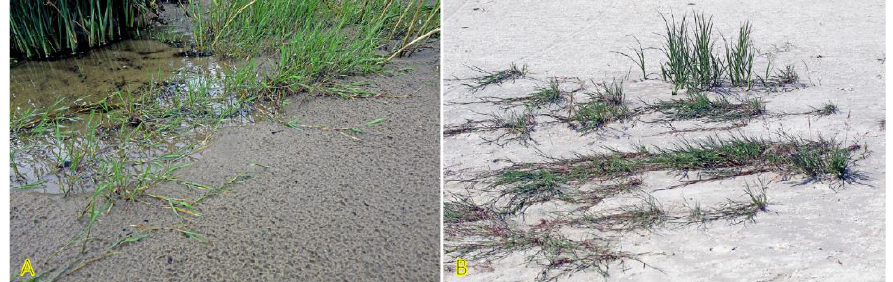
Figure 1. Agrostis stolonifera plants on a flooded wet sandy beach together with Bolboschoenus mari- timus in Lielupe, Jūrmala, Latvia ( A ) and a relatively dry sandy beach together with